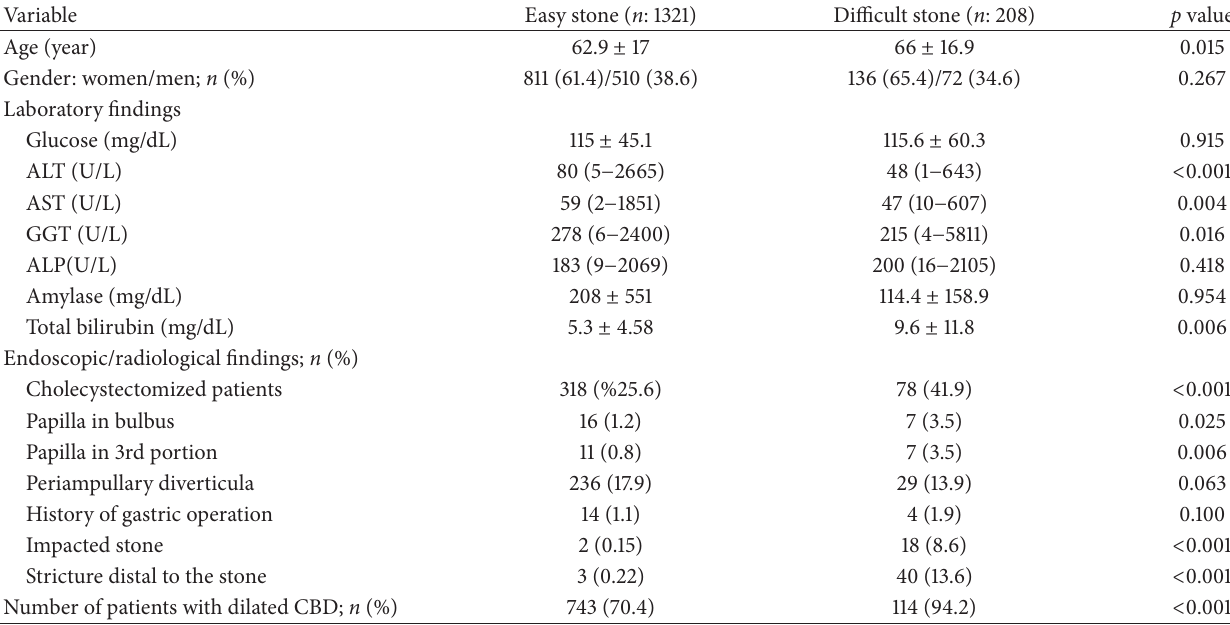
Table 1: Main differences between patients with easy and difficult